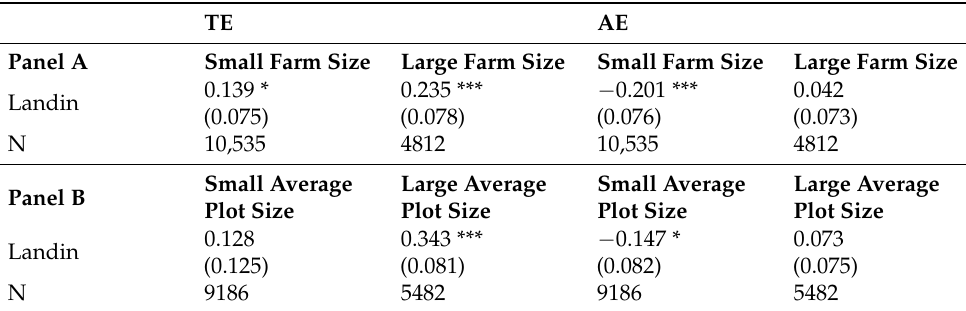
Table 9. Land rented in, the effect of farm size on household